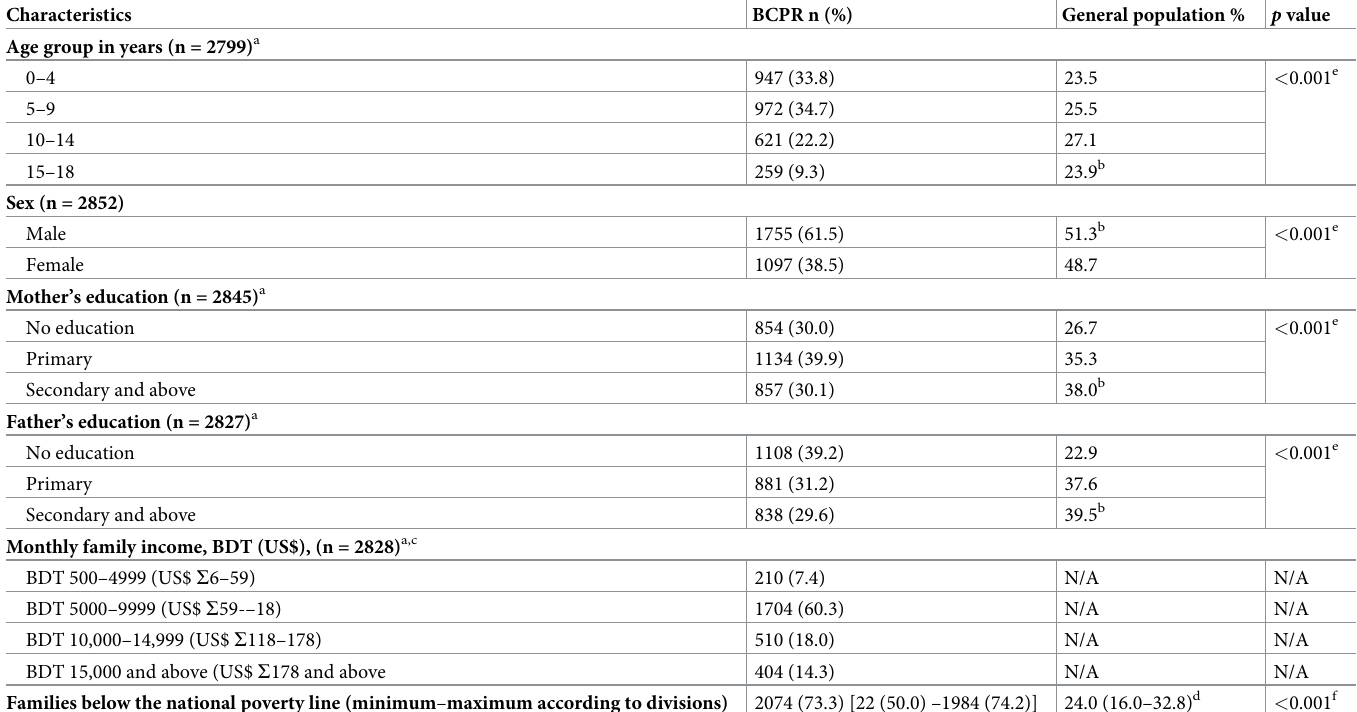
Table 1. Socio-demographic characteristics of children with